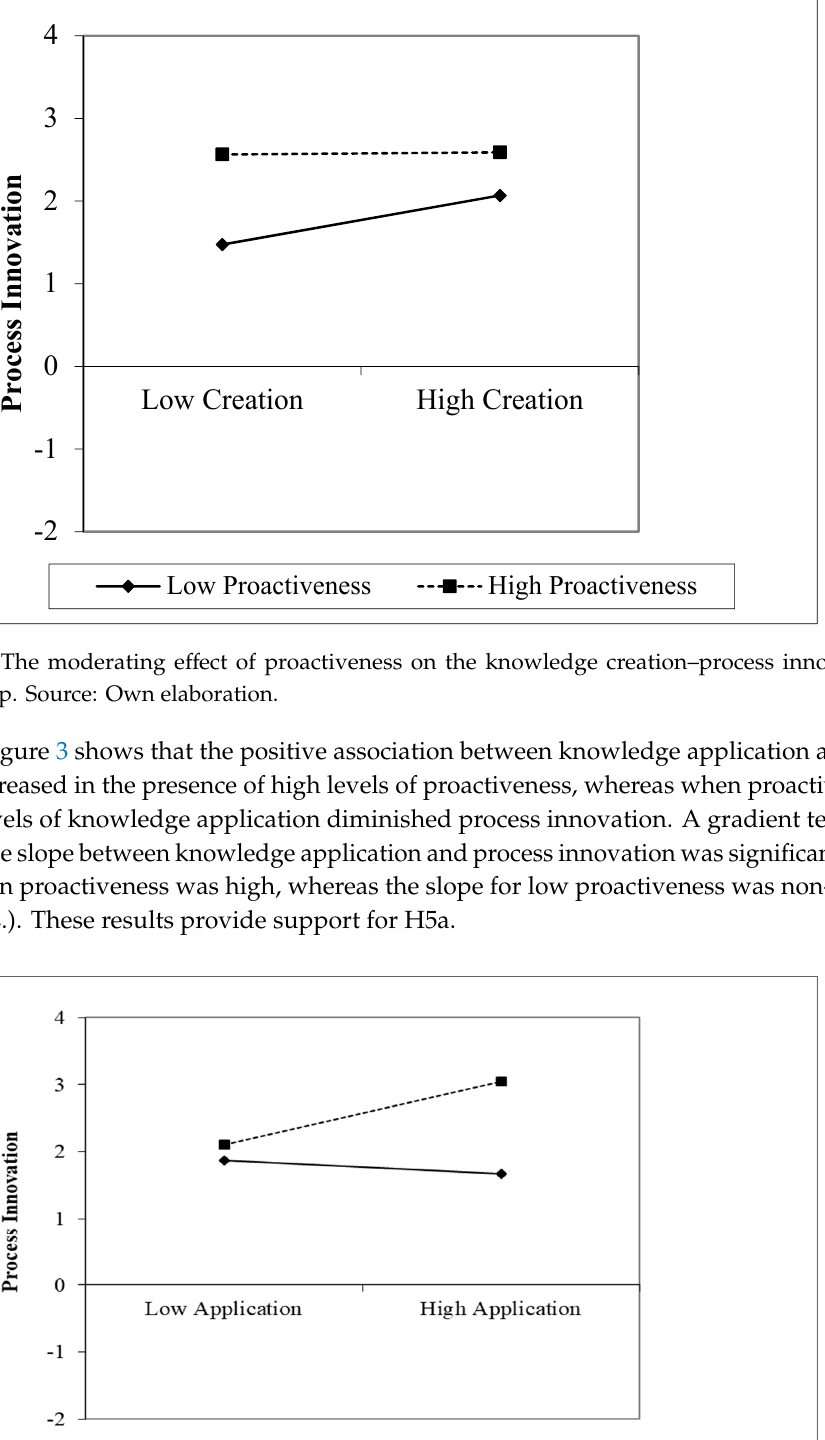
Figure 3. The moderating effect of proactiveness on the knowledge application–process innovation relationship. Source: Own elaboration.